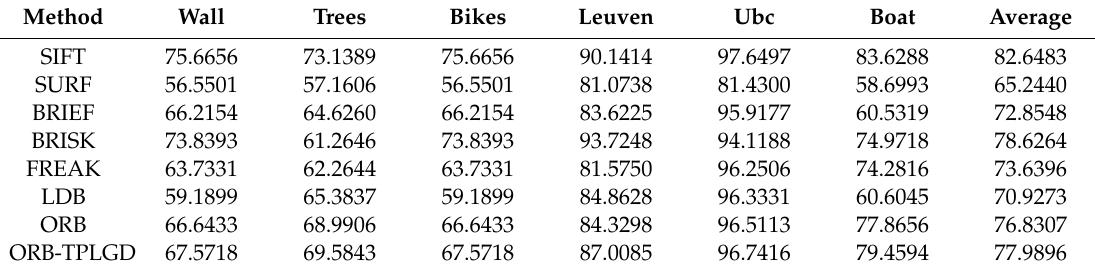
Table 4. Average matching precision based on Oxford dataset